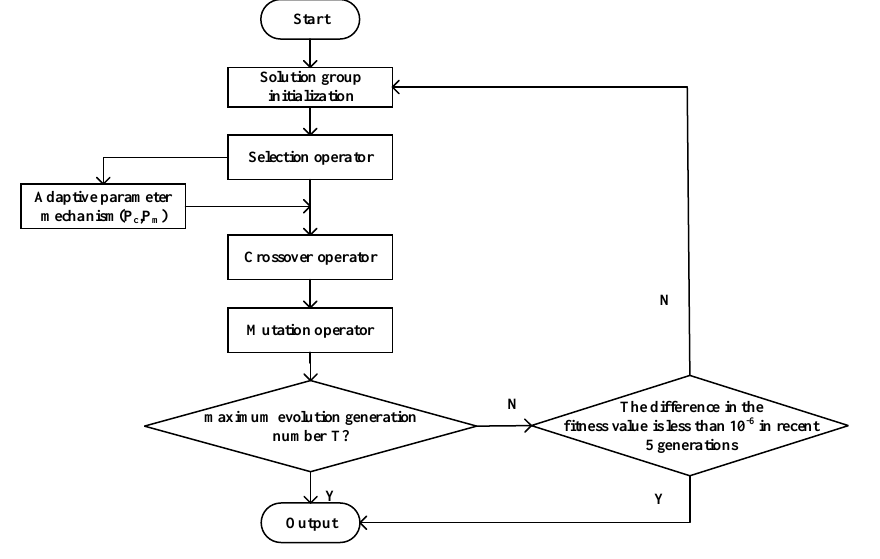
Figure 7. Algorithm